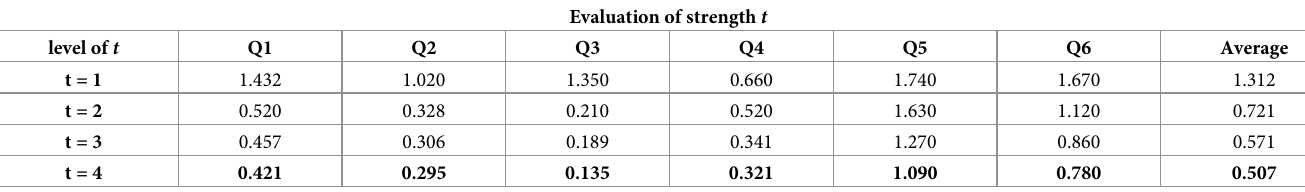
Table 3. Evaluation of level of strength t (best results in